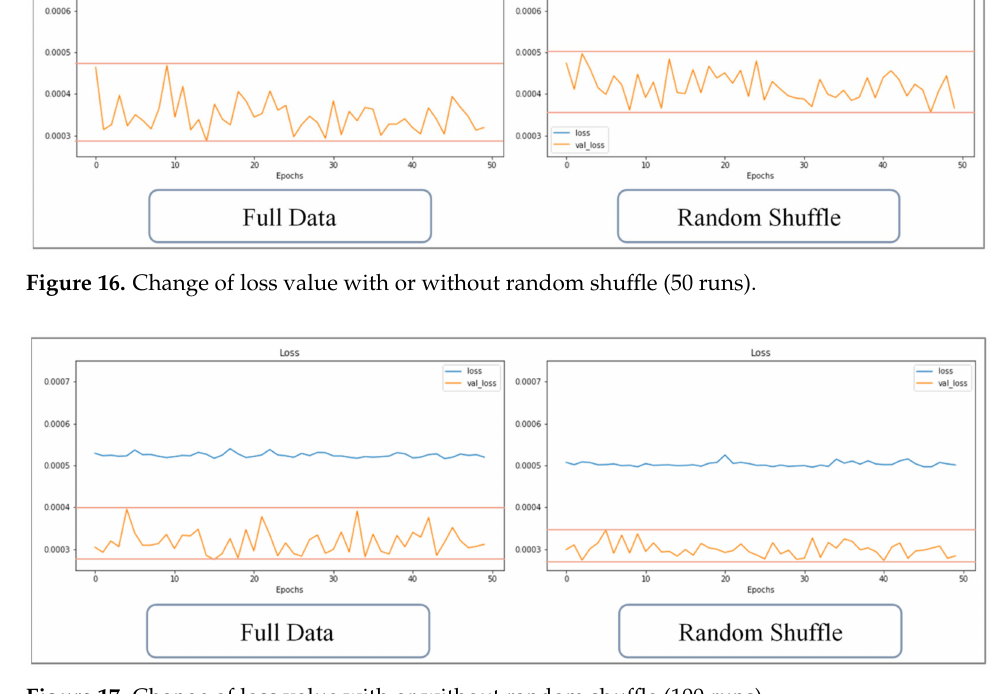
Figure 17. Change of loss value with or without random shuffle (100